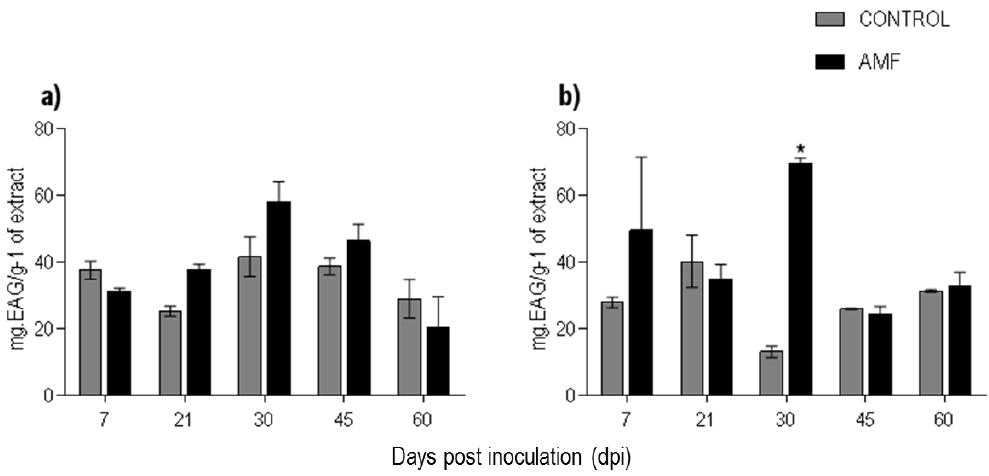
Figure 6. Total phenolic compounds in Piper nigrum L. ( a ) leaves and ( b ) roots. Asterisks on the bars represent statistically significant di ff erences between the treatment and control groups, at the 5% probability level, by Bonferroni.